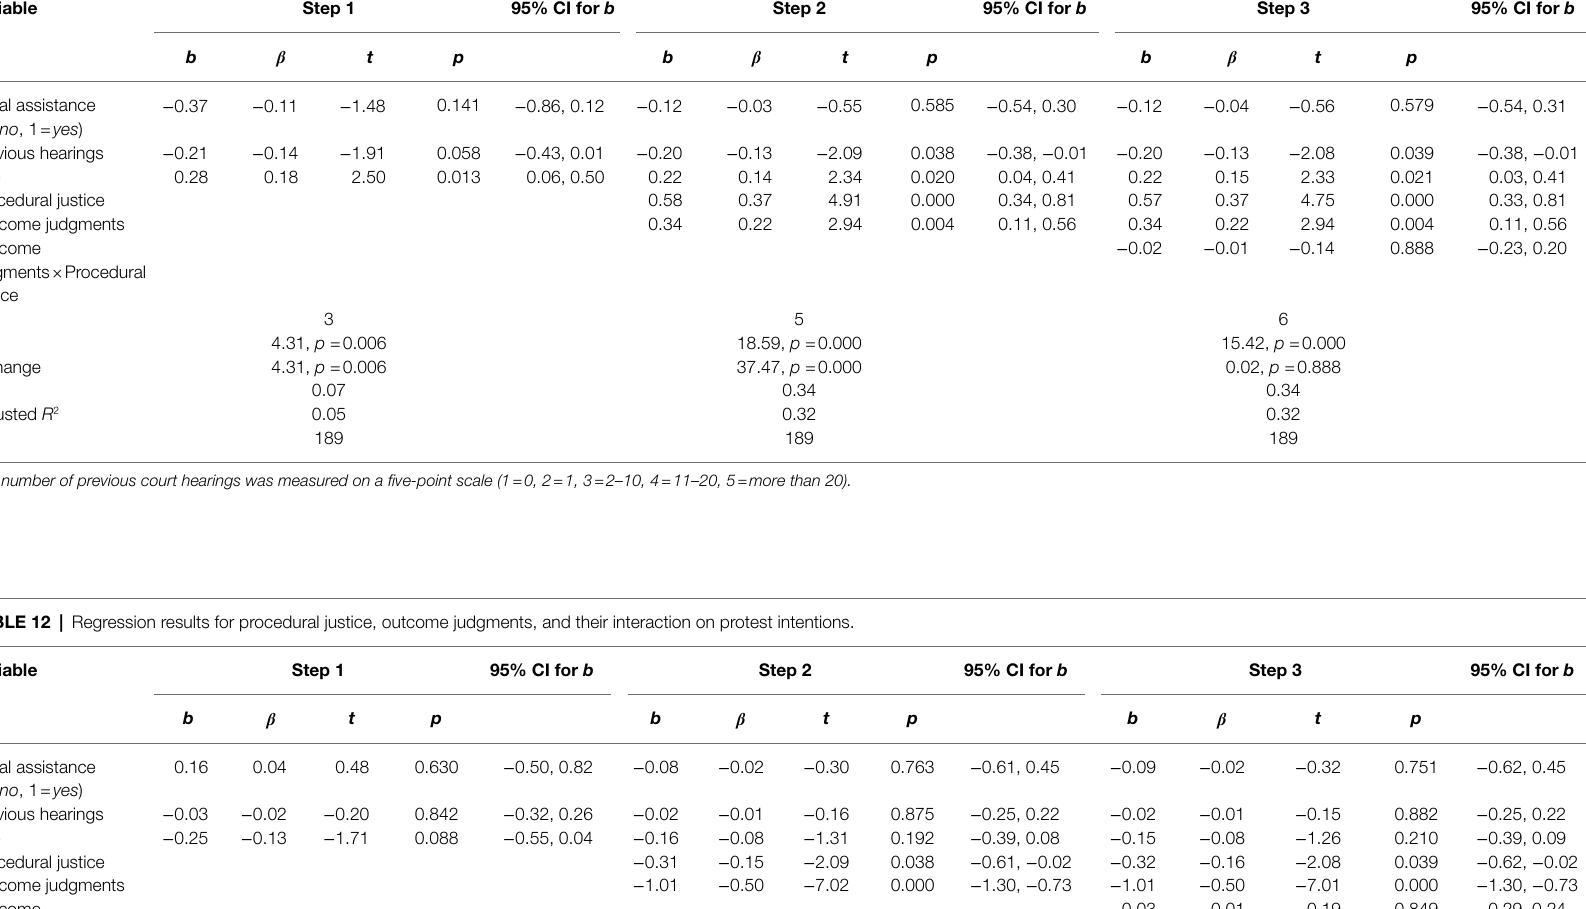
TABLE 11 | Regression results for procedural justice, outcome judgments, and their interaction on trust in judges. Variable